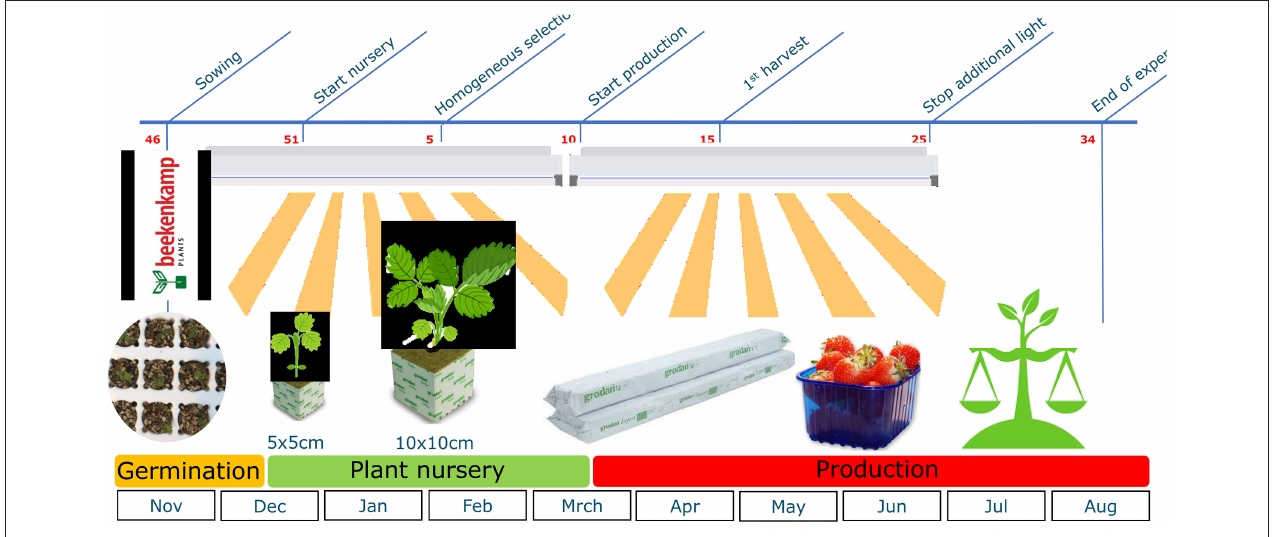
FIGURE 1 | Strawberry cropping cycle